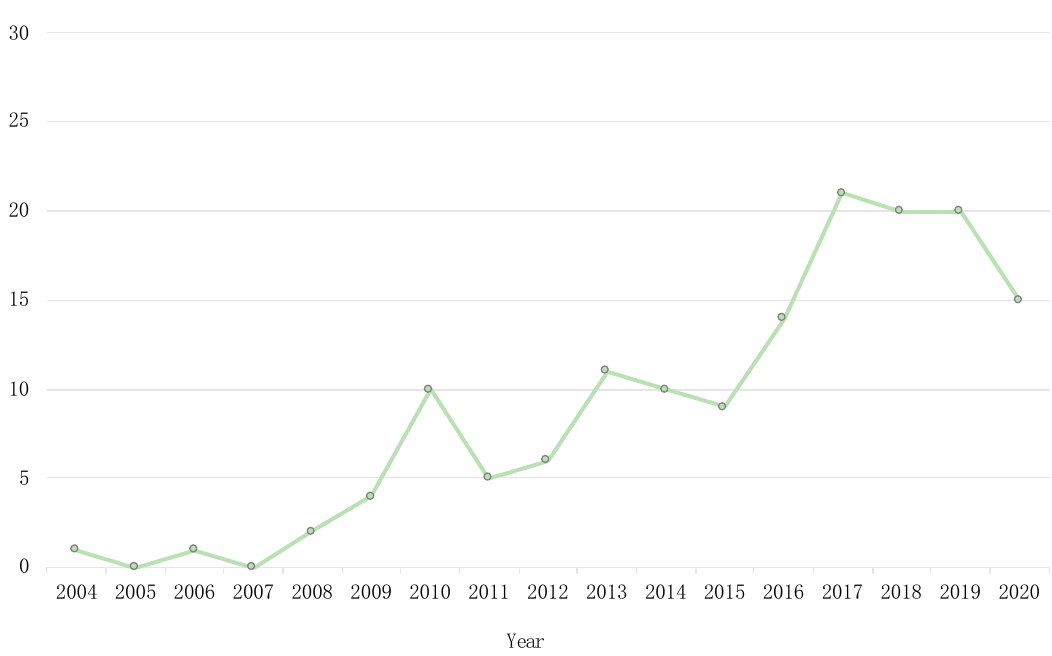
Figure 1. Trends of publication of cephalosporinases reported in wildlife since its first description in 2004.